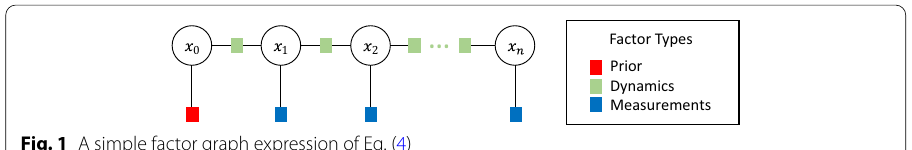
Fig. 1 A simple factor graph expression of Eq.